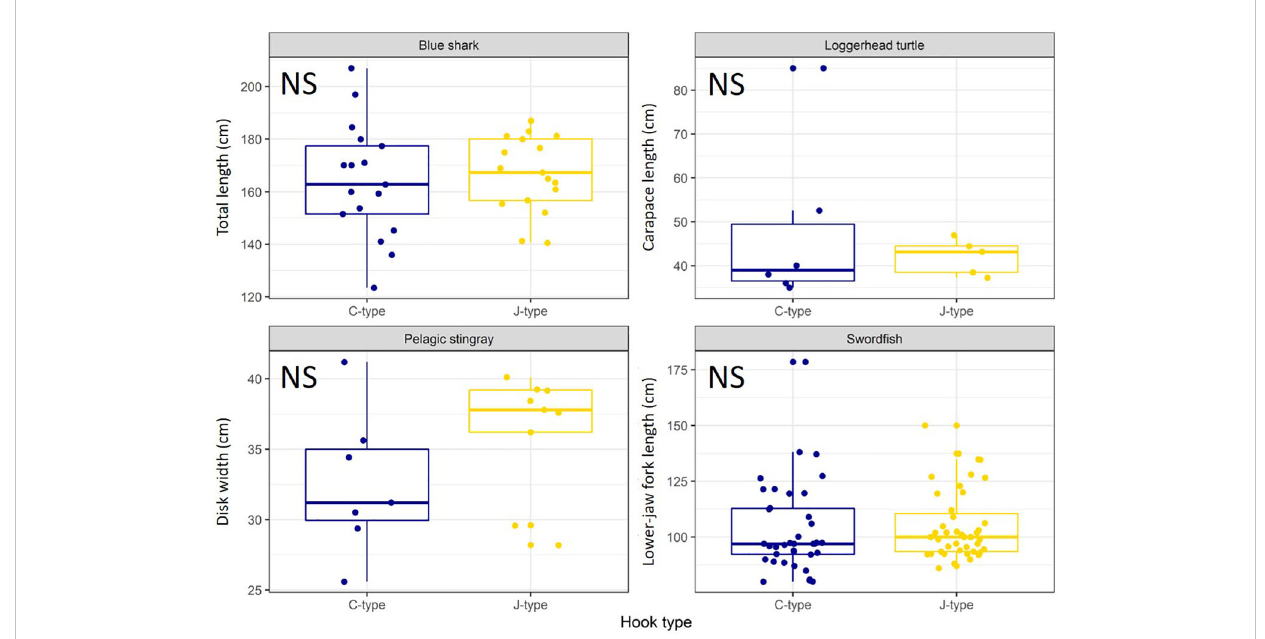
FIGURE 5 Box plot of body size in centimeters (total length for blue sharks, carapace length for Loggerhead turtle, lower-jaw fork length for sword fi sh, and disc width for dark stingrays) by hook type (C and J). No signi fi cant (NS) differences were found between the hook types (Wilcoxon ’ s test; p